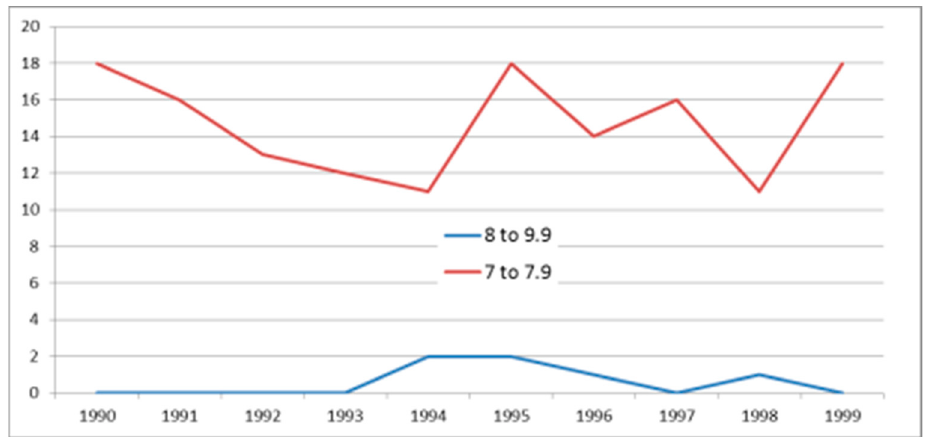
Figure 4. Earthquake magnitude worldwide. Source: Authors’ processing is based on data available on http://earthquake.usgs.gov/earthquakes/eqarchives/year/info_1990s.php (accessed on 20 July 2017).